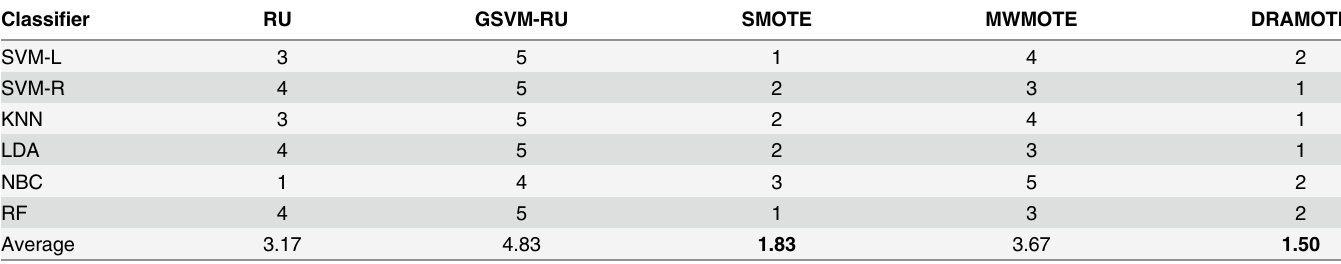
Table 3. Ranking of methods based on F 1 Score for every classifier. Classi fi